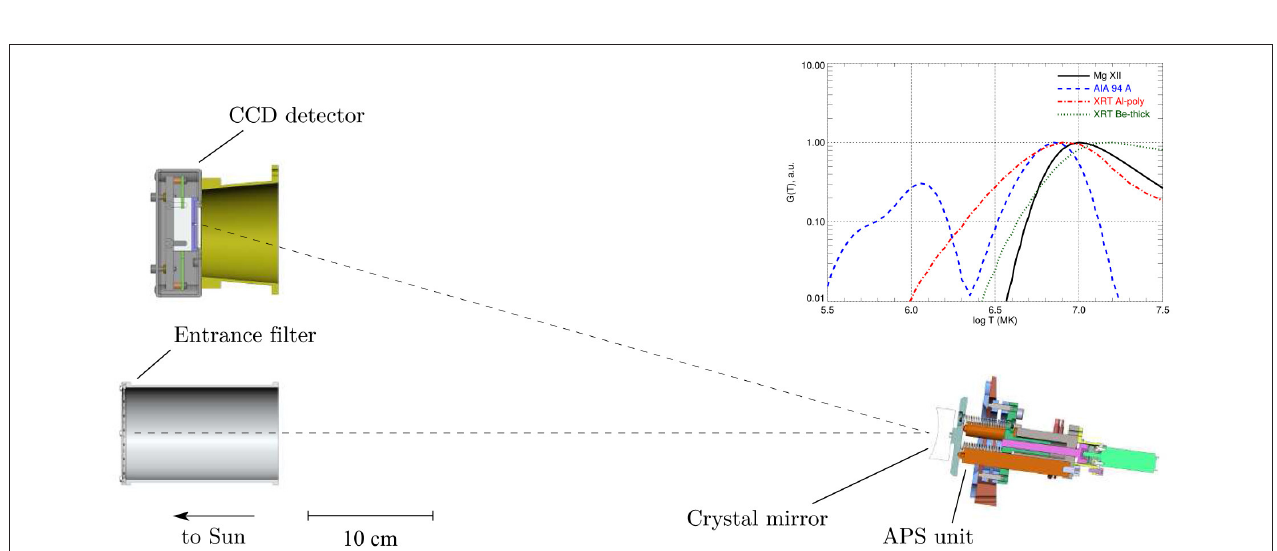
FIGURE 4 | A cross sectional view of the Monochromatic X-ray Imager (MXI) inside the KORTES-SU assembly. Top-right corner: the temperature response function of MXI in comparison with SDO/AIA and Hinode/XRT. MXI is sensitive only to “hot” (T>4 MK) plasma component in contrast to other imagers.